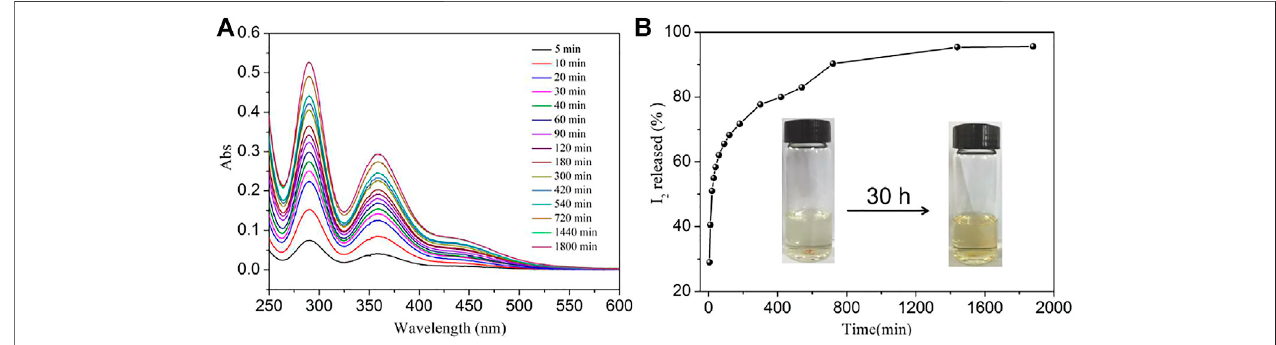
FIGURE 5 | (A) Temporal evolution of UV – Vis absorption spectra for the release of iodine from NS-1 9 in ethanol and (B) the rate of iodine release from NS-1 9 in ethanol.